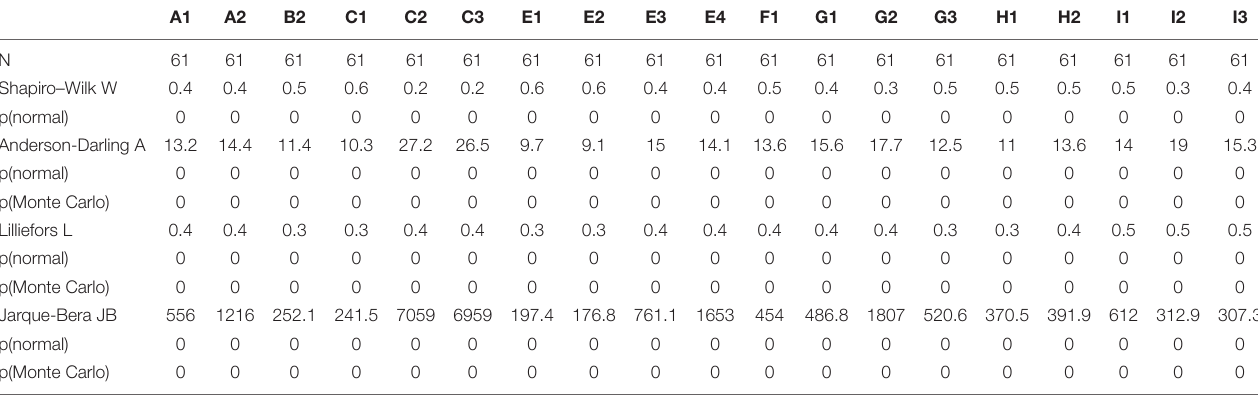
TABLE 5 | Normality tests for phytolith